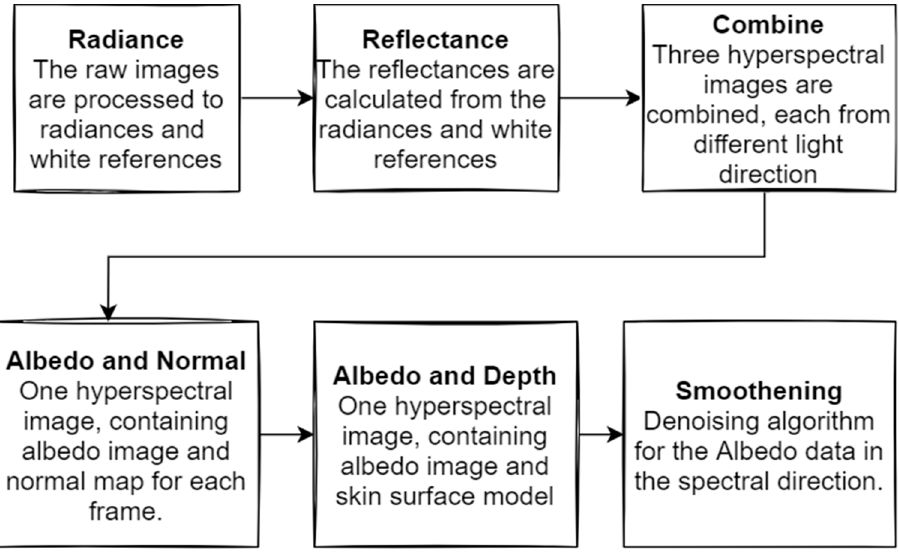
Figure 2. Raw-image pre-processing. The detailed process and mathematical formulas can be found in [18] .